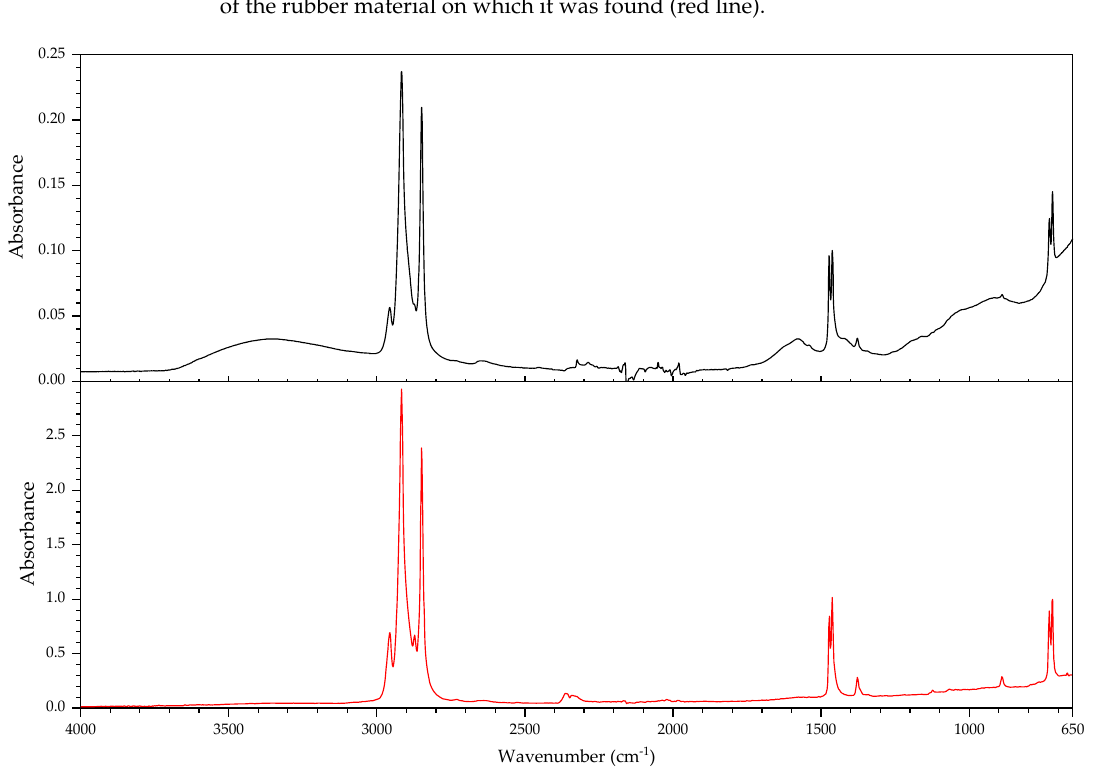
Figure 23. FTIR spectrum of the blooming of object 594 (black line) compared to reference spectrum of a mineral wax (paraffin, red line) from a commercial database.